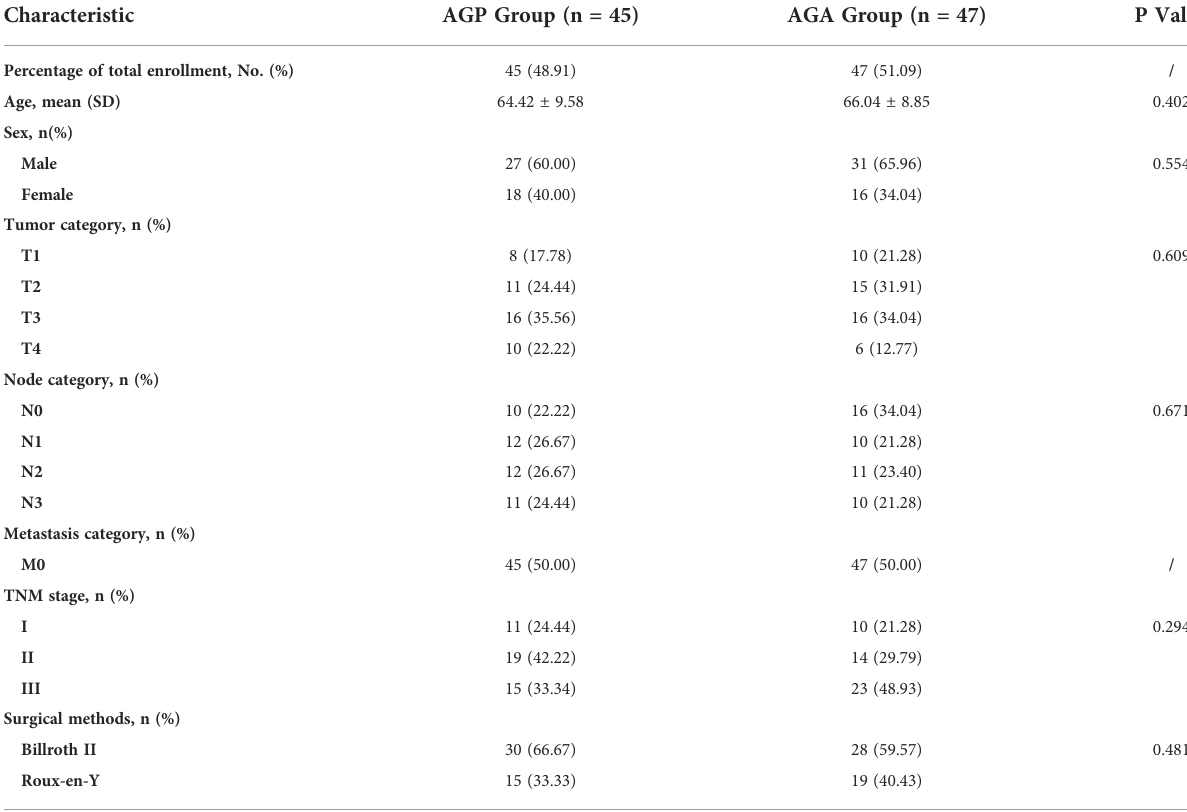
TABLE 1 Baseline patient demographics and characteristics.